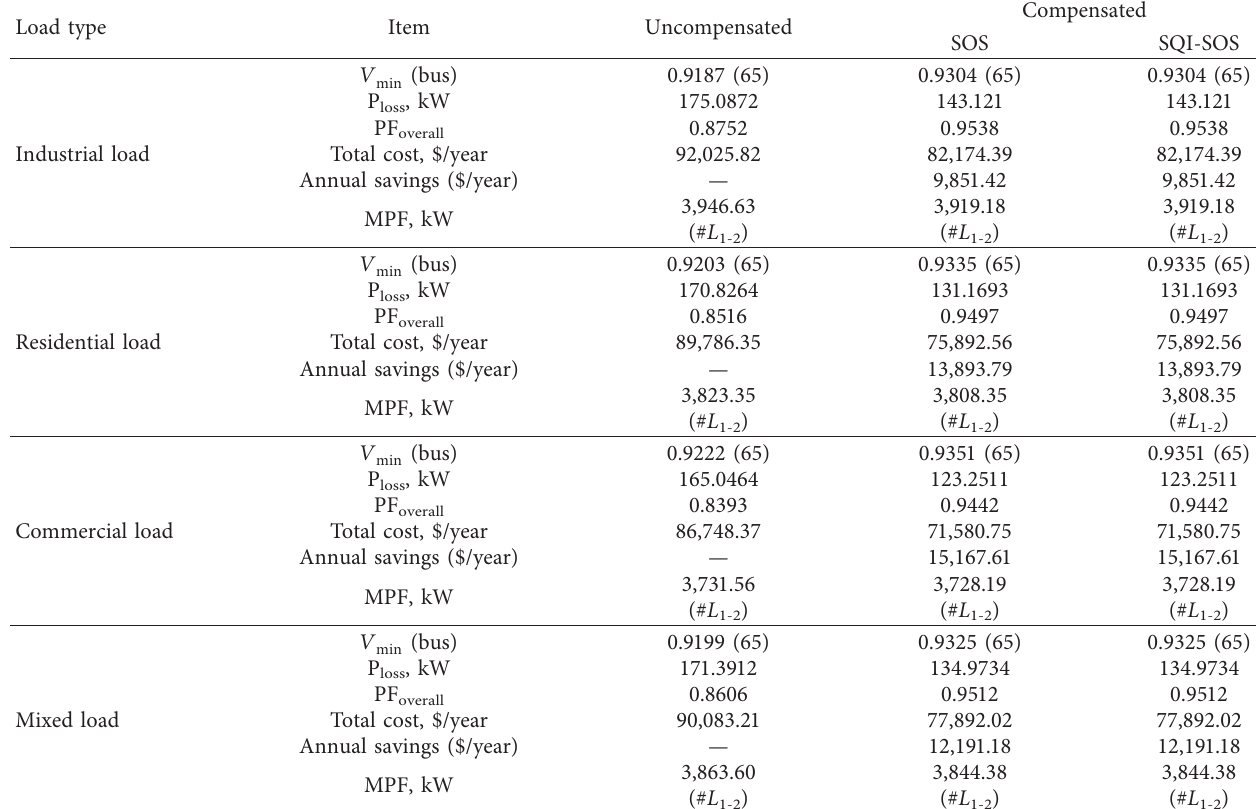
Table 12: Comparative results of the 69-bus system after compensation with different load models. Load